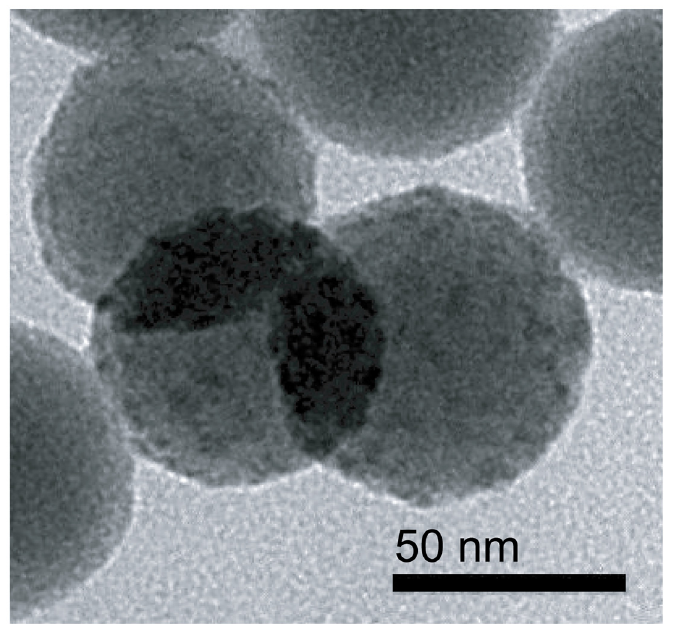
Fig 8. TEM of BC-EDTA/Eu 3+